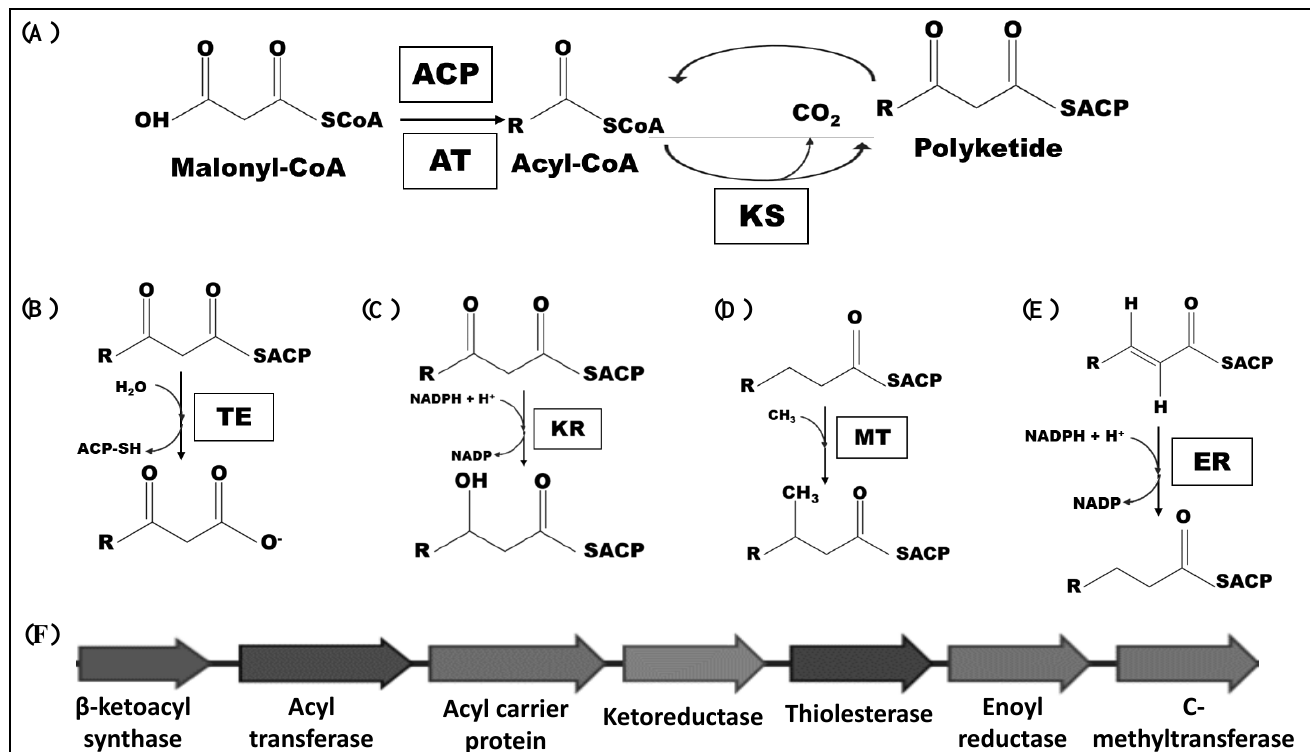
Figure 3. ( A ) Scheme of polyketide biosynthesis by polyketide synthetase. AT—Acyl transferase;